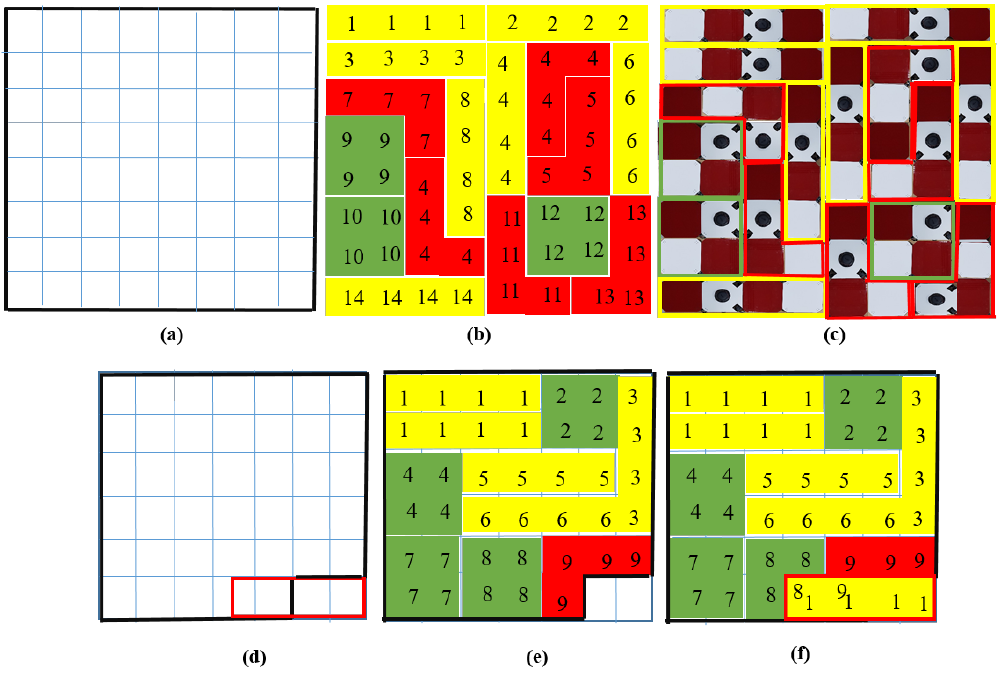
Figure 5. Tilesets by tiling theory and hTetro morphologies fitting inside the tilesets. ( a ) 8 × 8 workspace; ( b ) tileset; ( c ) hTetro morphologies fit in platform; ( d ) partially overlapped sub-workspaces of 6 × 7 workspace; ( e ) tileset for sub-workspace; ( f ) tileset for 6 × 7 workspace with overlapped